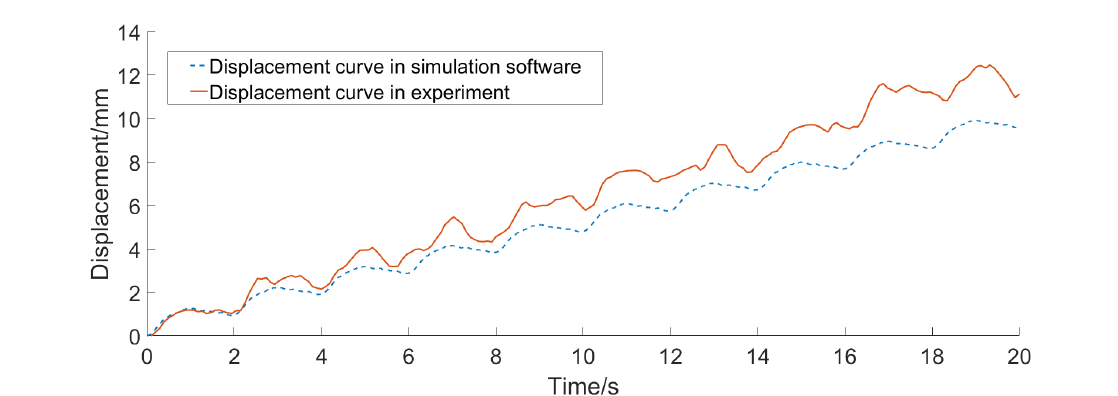
Figure 16. Comparison between simulation and experiment displacement curves of worm configuration.